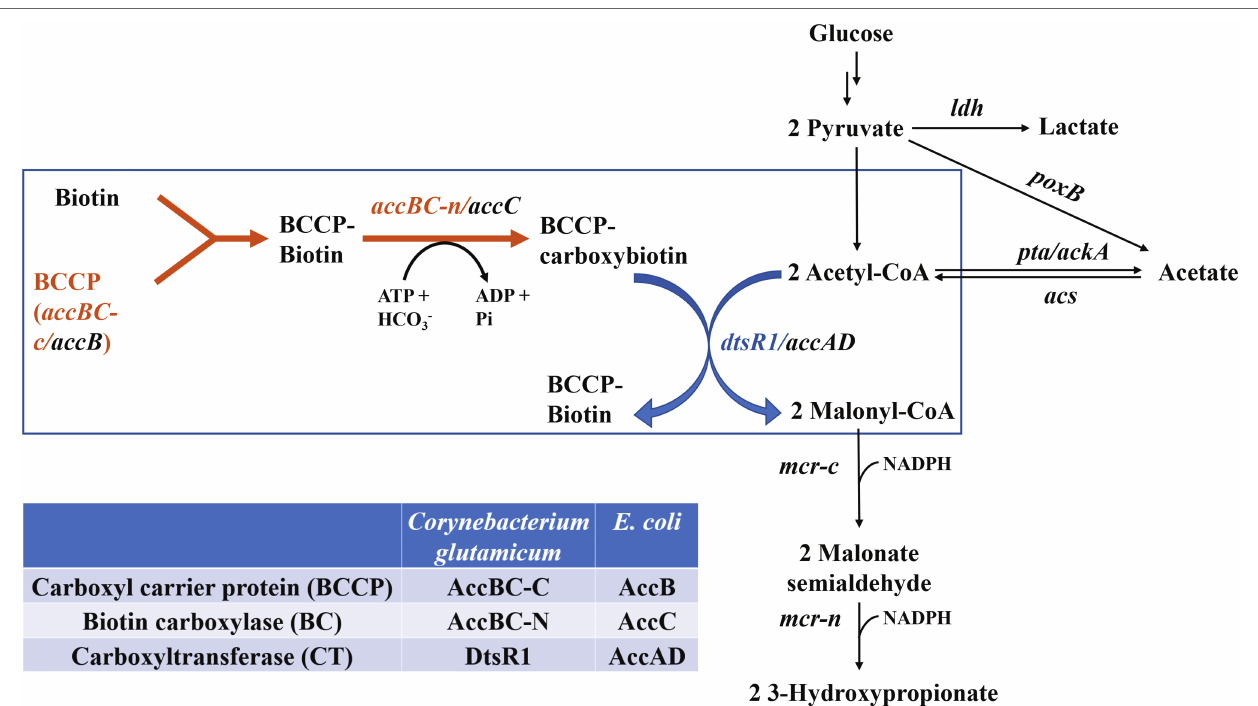
FIGURE 1 | Biosynthesis of 3-HP through the malonyl-CoA pathway by regulating the expression of Corynebacterium glutamicum –derived Acc . ldh , lactate dehydrogenase; poxB , pyruvate oxidase; pta/ackA , acetate acetyltransferase/acetate kinase; acs , acetyl-coenzyme A synthetase; mcr-c , C-terminal of mcr (malonyl-CoA reductase); mcr-n , N-terminal of mcr